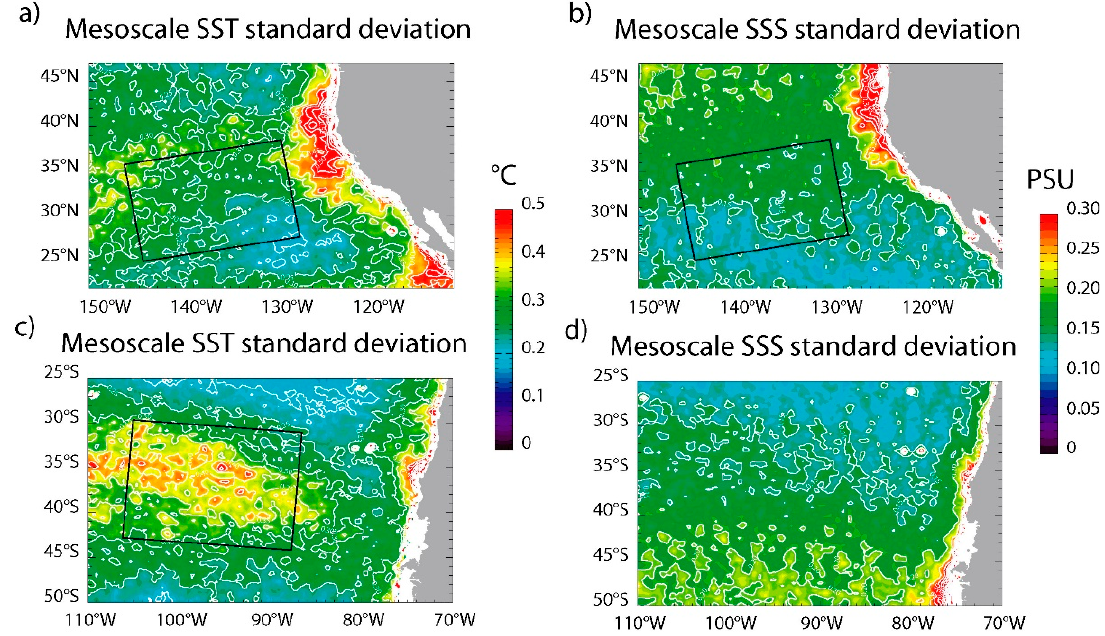
Figure A3. Standard deviation of spatially high-pass filtered ( a , c ) AMSR-2 SST (°C) and ( b , d ) SMAP SSS (PSU) in the ( a , b ) ENP and ( c , d ) ESP. The tilted boxes on ( a – c ) are as in Figures 2a,c and 3a, respectively.